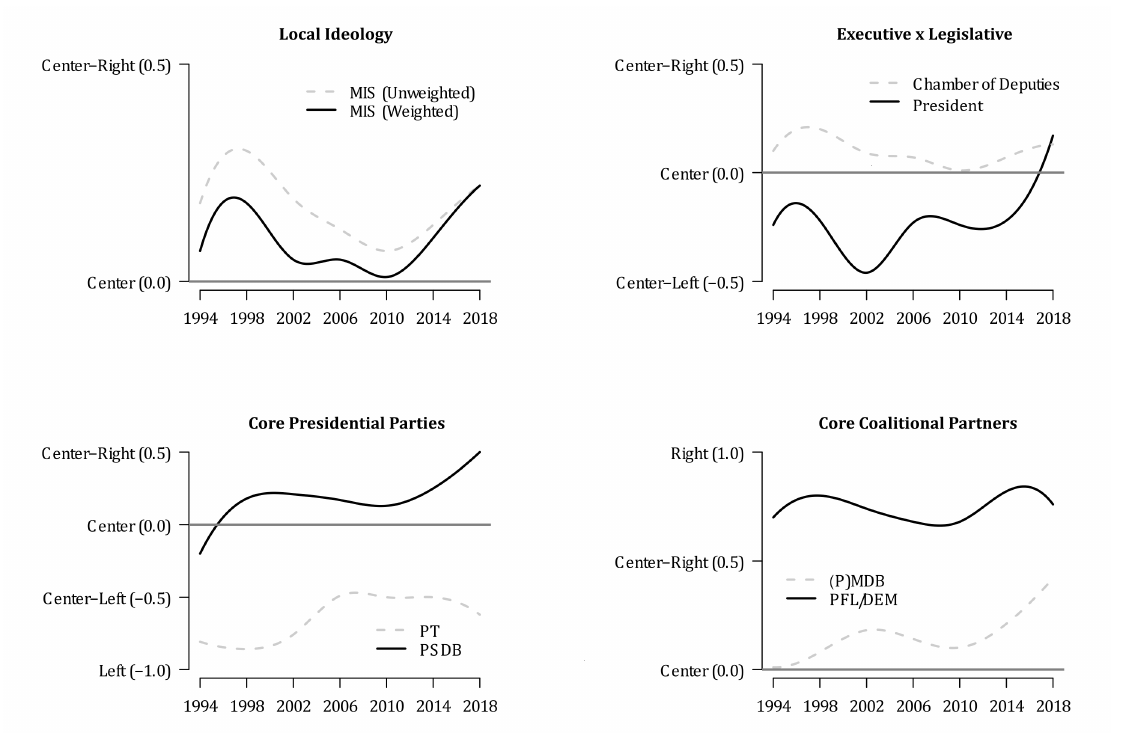
Figure 3: Local Ideology, Chamber of Deputies Composition, Presidential Voting, and Dominant Parties